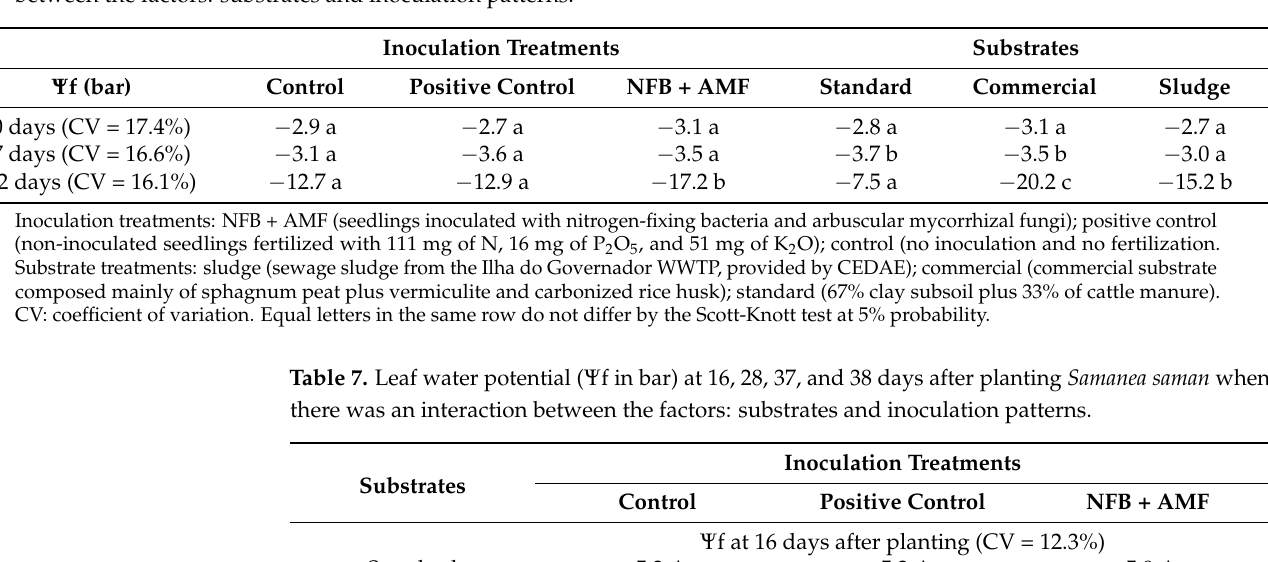
Figure 1. Root dry mass (RDM) and shoot dry mass (SDM) of Samanea saman plants, in which seedlings were produced with different inoculation patterns and substrates. Equal lower-case letters for inoculation patterns ( a ) and equal upper-case letters for substrate ( b ) do not differ from each other by Scott-Knott test at 5% of probability. Letters inside the black bars refer to seedlings’ dry mass before planting (CV = 7.2 and 10.2% respectively for SDM and RDM), inside white bars to their increment during the 66 days of the experiment (CV = 23.2 and 17.2% respectively for SDM and RDM), and out of the bars for the total dry mass at 66 after planting (CV = 12.1 and 9.1% respectively for SDM and RDM). Inoculation treatments: NFB + AMF (seedlings inoculated with nitrogen-fixing bacteria and arbuscular mycorrhizal fungi); PC = positive control (non-inoculated seedlings fertilized with 111 mg of N, 16 mg of P 2 O 5 , and 51 mg of K 2 O); C = control (no inoculation and no fertilization). Substrate treatments: sludge (sewage sludge from the Ilha do Governador WWTP, provided by CEDAE); commercial (commercial substrate composed mainly of sphagnum peat plus vermiculite and carbonized rice husk); standard (67% clay subsoil plus 33% of cattle manure). Table 6. Leaf water potential (Ψf in bar) at 0, 7, and 22 days after planting Samanea saman when there was no interaction between the factors: substrates and inoculation patterns.